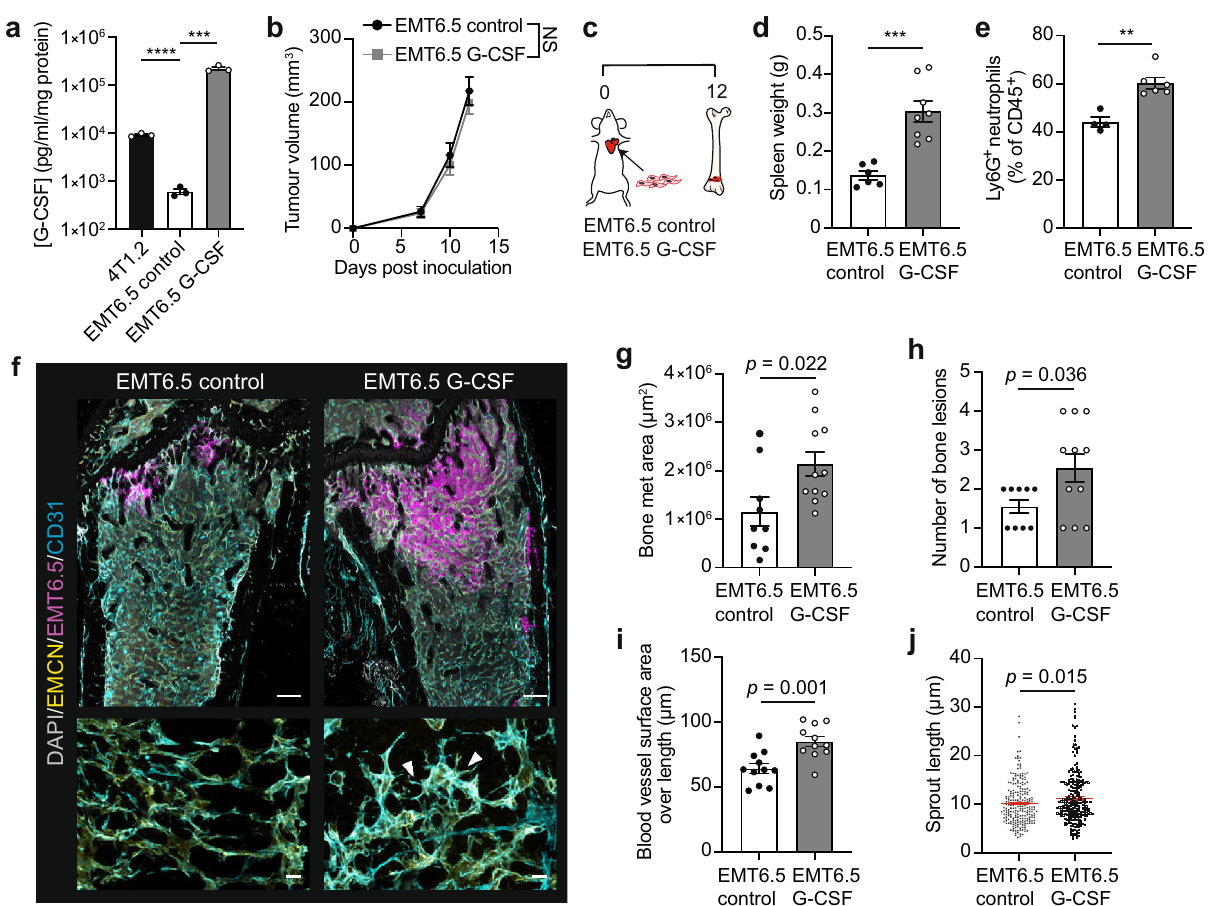
Fig. 5 Tumoral G-CSF drives BM vascular remodelling and enhances bone metastasis development. a ELISA for G-CSF in cell media of 4T1.2, EMT6.5 control and EMT6.5 G-CSF cells. n = 3 per cell line. *** P = 0.0004, **** P < 0.0001 by two-tailed unpaired t tests. b Orthotopic tumour growth of EMT6.5 control ( n = 10 mice) and EMT6.5 G-CSF cells ( n = 8 mice). P value, two-way repeated measures ANOVA (days 0 − 12). c Experimental plan to test the effect of cancer cell-secreted G-CSF on bone metastasis . d , e Spleen weight ( d ) and quanti fi cation of circulating Ly6G + neutrophils ( e ) at experimental endpoint. For ( d ), n = 6 (control) and 8 mice (G-CSF). For ( e ), n = 4 (control) and 6 mice (G-CSF). ** P = 0.001, *** P = 0.0003 by two-tailed unpaired t tests. f 3D images (top) and enlarged micrographs (bottom) of femur from mice injected with control or G-CSF-expressing EMT6.5 cells. Bones were stained for DAPI (grey), EMT6.5 cells (magenta), EMCN (yellow) and CD31 (cyan) ( n = 9 mice per cell line). Arrowheads indicate endothelial sprouts. Scale bars: 200 µ m (overviews), 20 µ m (enlargements). g , h Measurement of lesion area ( g ) and number ( h ) from ( f ). n = 9 (control) and 11 mice (G-CSF). P values, two-tailed unpaired t tests. i , j Quanti fi cation of surface area over vessel length ( i ) and sprout length ( j ) of blood vessels in macroscopic bone lesions from mice harbouring control and G-CSF-expressing EMT6.5 cells. Individual dots are from one vessel ( i ) or sprout ( j ). For ( i ), n = 4 (control) and 5 mice (G-CSF). For ( j ), n = 3 mice per group. P values, two-tailed unpaired t tests. All data re fl ect mean ± s.e.m. NS not signi fi cant. Source data are provided as a Source Data fi